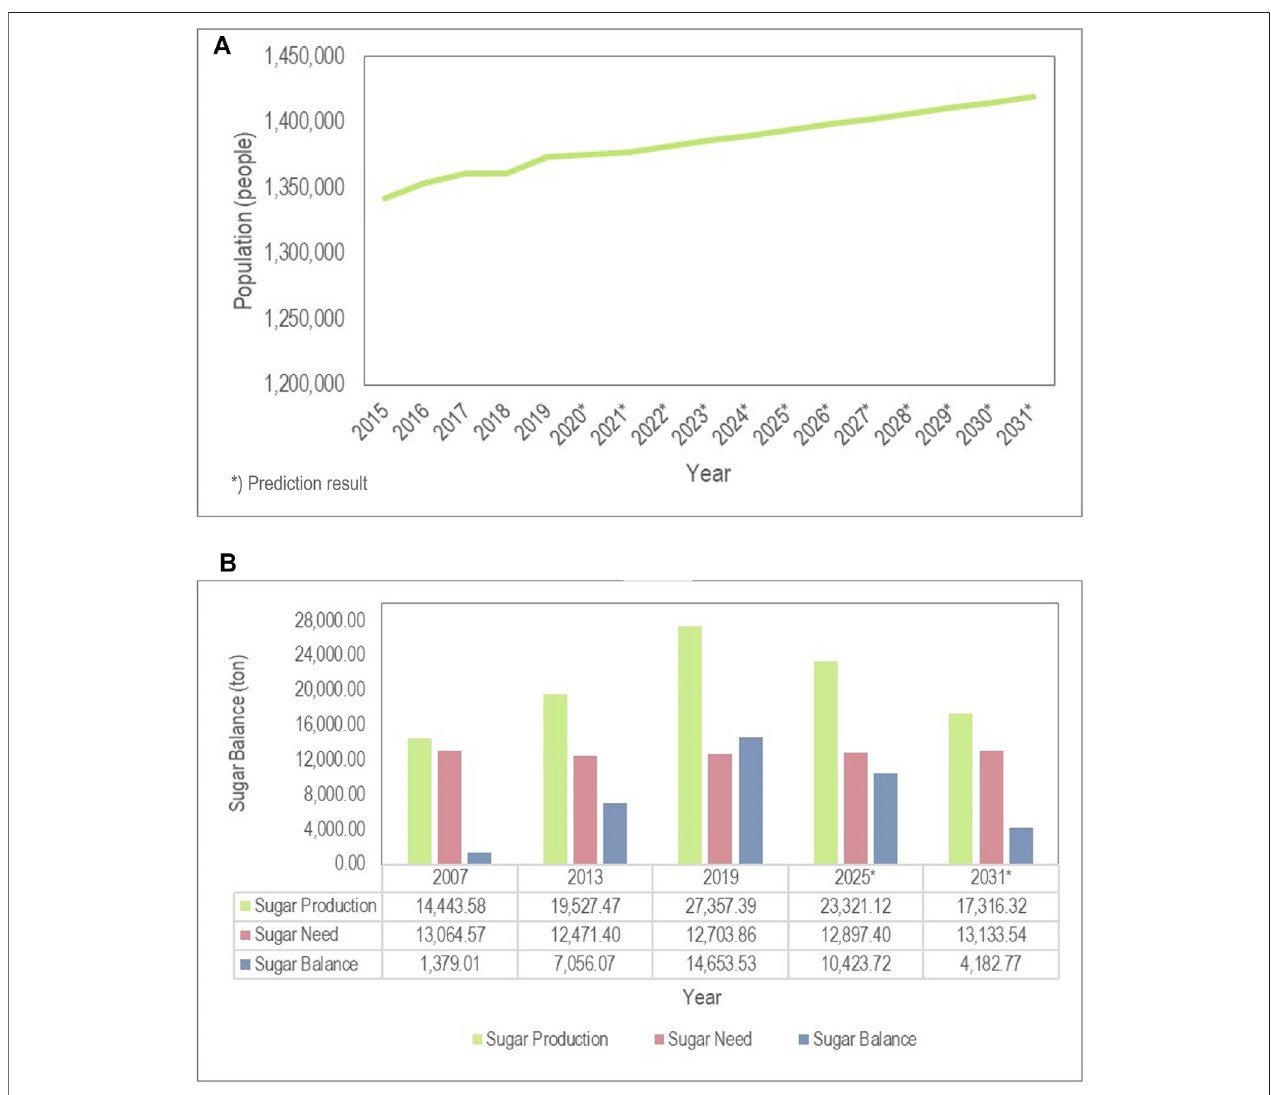
FIGURE 3 | The population projection result in Lamongan Regency until 2031 (A) ; the sugar balance in 2007, 2013, 2019, 2025, and 2031 (B) .